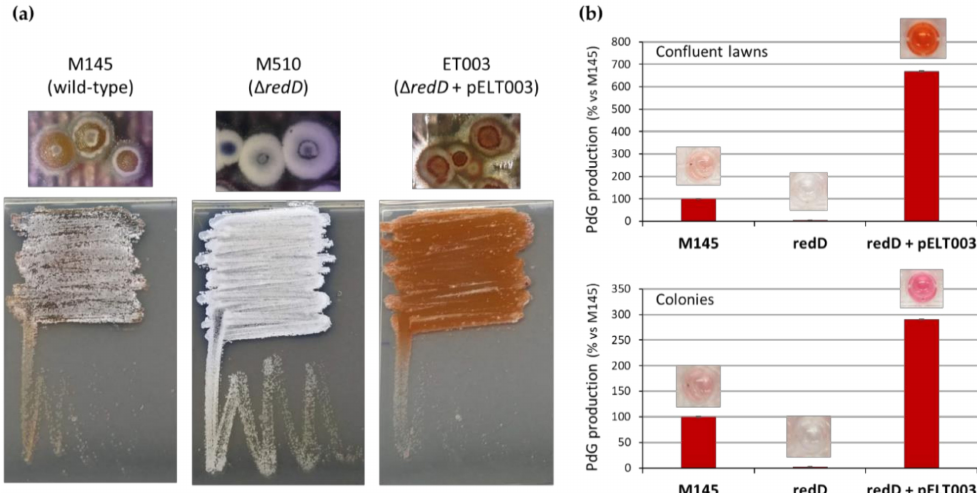
Figure 2. Multiple copies of redD results in higher PdG production, thereby blocking sporulation of S . coelicolor . ( a ) Phenotypes of 65 h old confluent lawns and single colonies of S . coelicolor M145 (wild-type, parental strain), M510 ( redD deletion mutant), and strain ET003 ( redD on the low-copy-number plasmid pIJ2587). ( b ) Semi-quantitative measurement of PdG synthesis in the three studied S . coelicolor strains revealing the overproduction of PdGs in ET003. Note that thiostreptone was not included in the medium for optimal comparison of strain ET003 with strains M145 and M510 that do not possess the tsr resistant gene present in